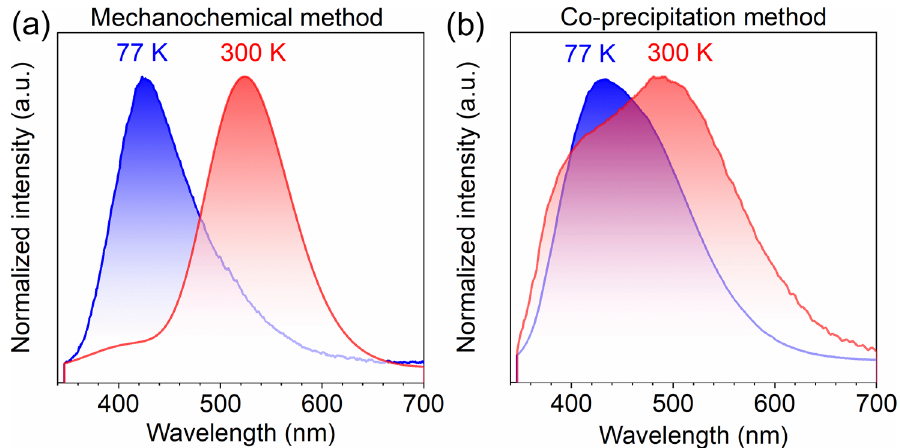
Figure 2. 77 K (blue line) and 300 K (red line) normalized emission spectra of undoped BMW samples synthesized by MC ( a ), CP ( b ) recorded under 266 nm excitation.